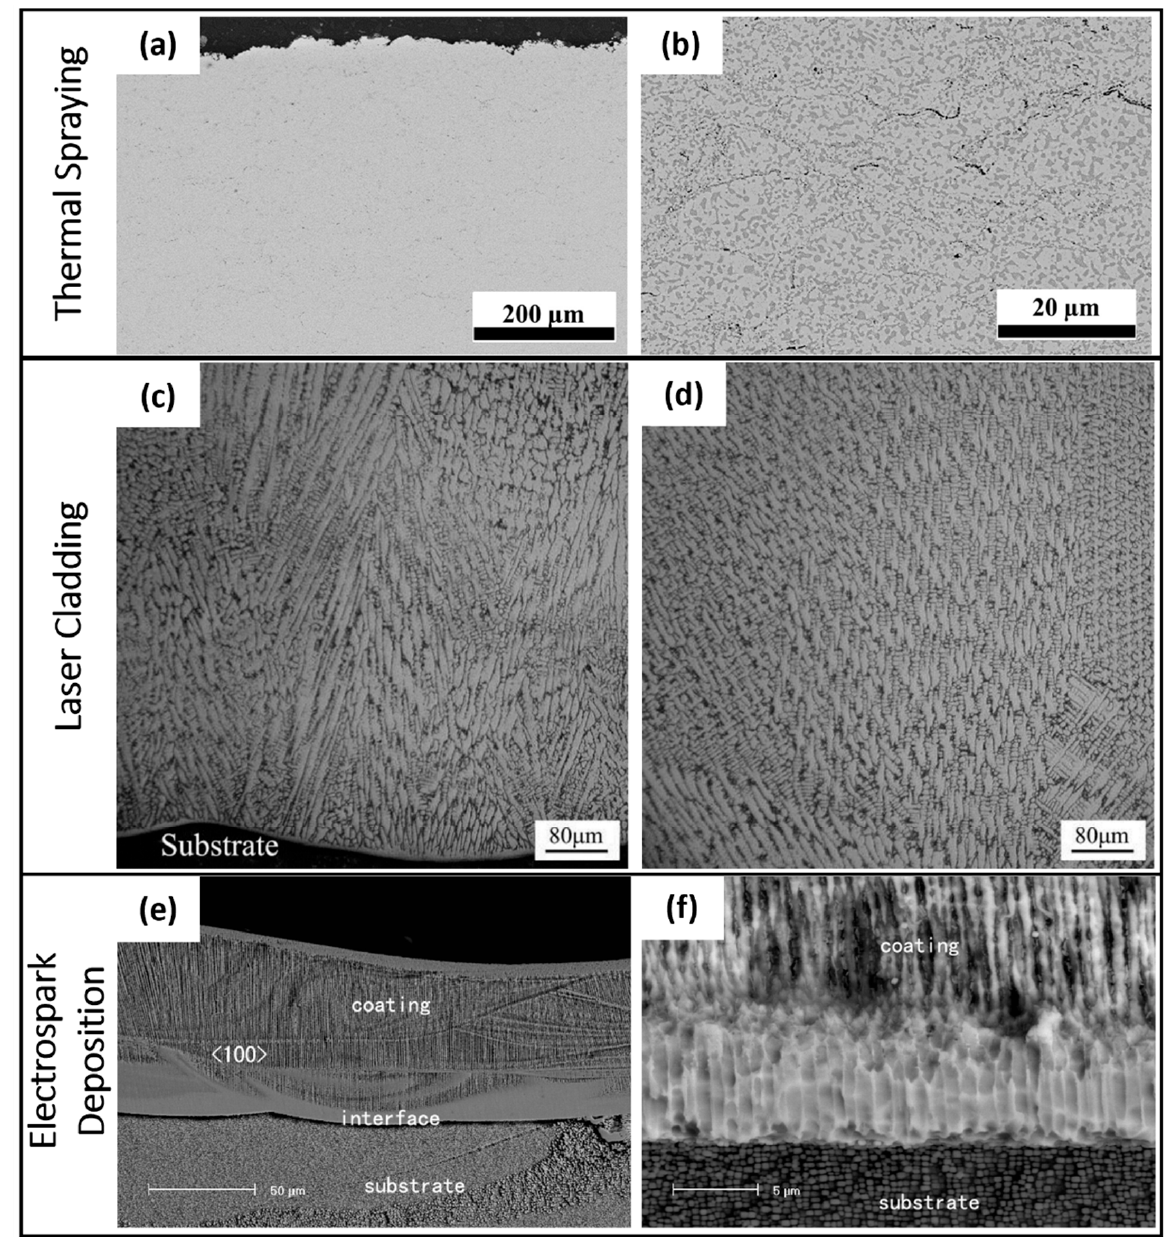
Figure 10. Typical microstructure of MCrAlY coatings produced by different techniques: ( a , b ) HVOF-sprayed CoNiCrAlY coating (Modified and reproduced from [145] with permission from Elsevier); ( c , d ) laser-cladded NiCrAlY coating (Modified and reproduced from [146] with permission from Elsevier); ( e , f ) electrospark-deposited NiCoCrAlYTa coating (Modified and reproduced from [147] with permission from